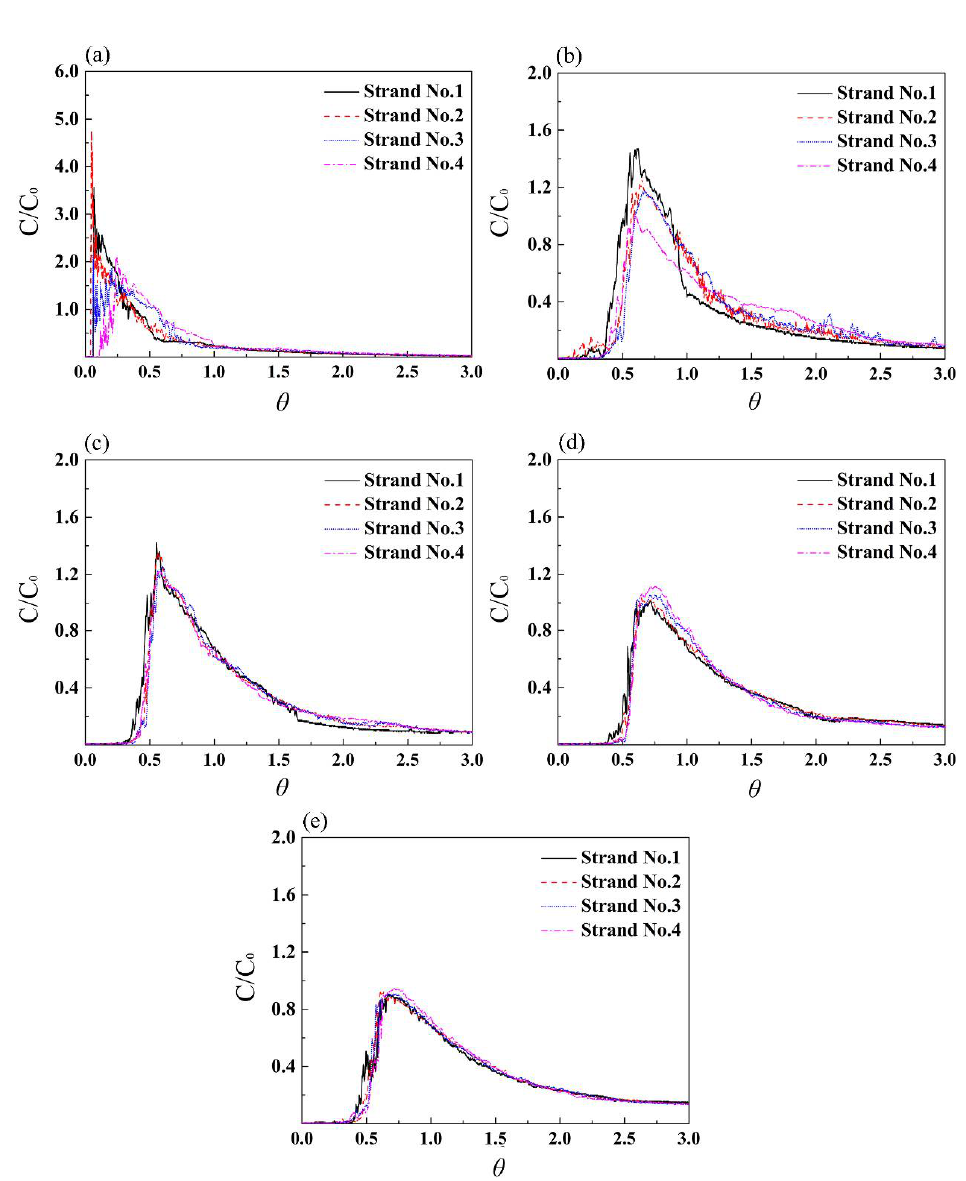
Figure 5. RTD curves of non-isothermal experiment at different Δ T : ( a ) case A0, ΔT = 0 °C; ( b ) A1, 5 °C; ( c ) A2, 10 °C; ( d ) A3, 20 °C; ( e ) A4, 30 °C.